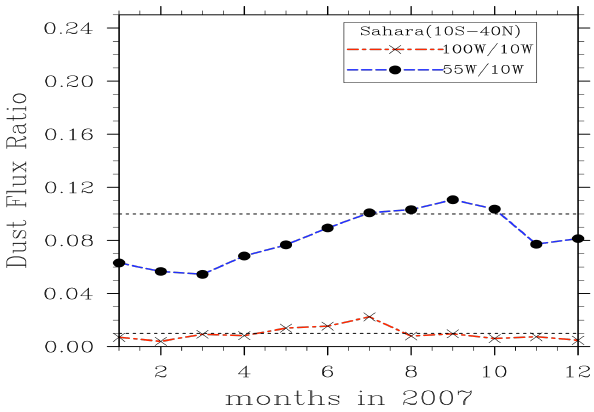
Fig. 4. Modeled monthly mean dust flux between 10 ◦ S to 40 ◦ N. The asterisk-marked line denotes the ratio of the flux as 100 ◦ W to that at 10 ◦ W, and the blue dashed-line denotes the ratio of the flux at 55 ◦ W to that at 10 ◦ W for Saharan dust in 2007. The dashed lines mark 0.1 and